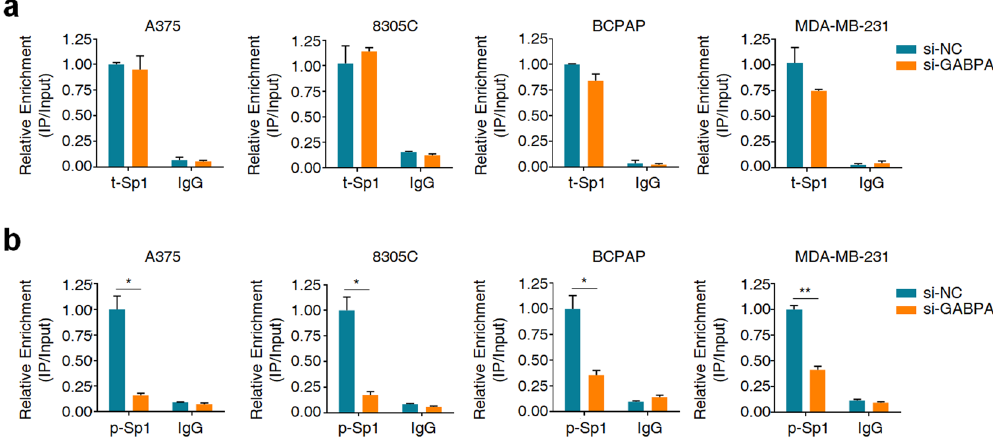
Fig. 5 GABPA knockdown reduces the recruitment of p-Sp1 to TERT promoter. ChIP-qPCR assay was performed to determine the effect of GABPA knockdown on the binding of t-Sp1 ( a ) and p-Sp1 ( b ) to TERT promoter in the indicated cells. Data were shown as mean ± SD. * P < 0.05; ** P < 0.01.